Question: In one sentence, what is this figure communicating?
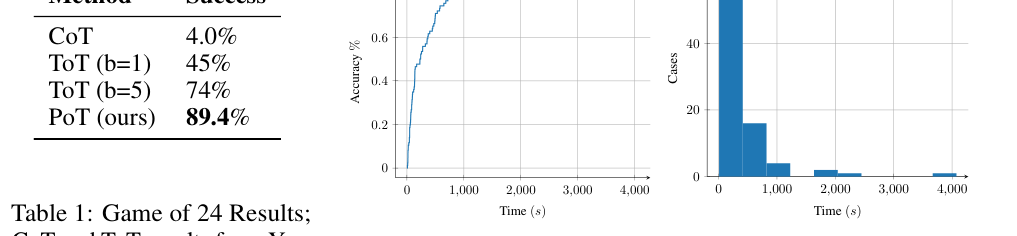
Answer: a) ROC curve by time b) Count by time to solve